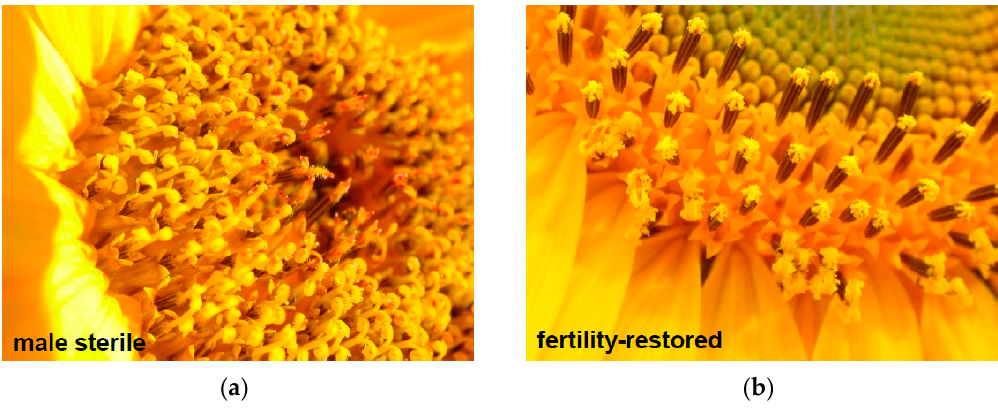
Figure 1. Inflorescence in the present of the CMS PET2 in a maintainer and restorer background. ( a ) CMS PET2 × RHA265, male sterile; ( b ) CMS PET2 × IH-51, fertility-restored hybrid.